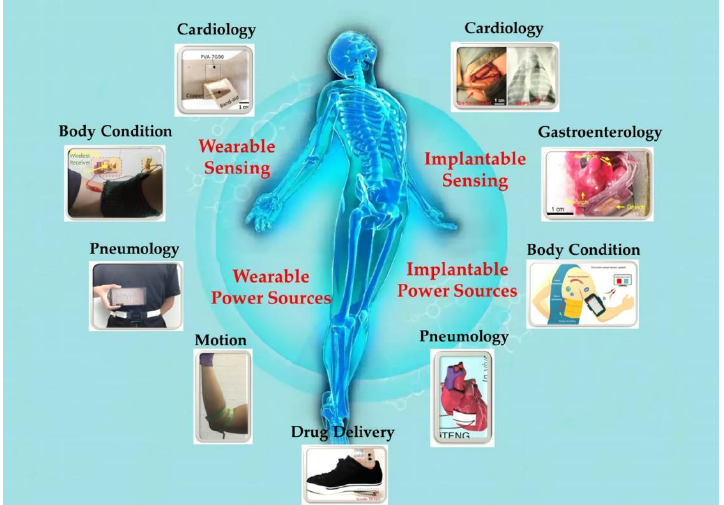
Figure 1. Schematic illustration of TENGs for biosensing, which includes wearable, implantable, and TENG as an external power source for third-party biosensors. TENG as an external power source for third-party